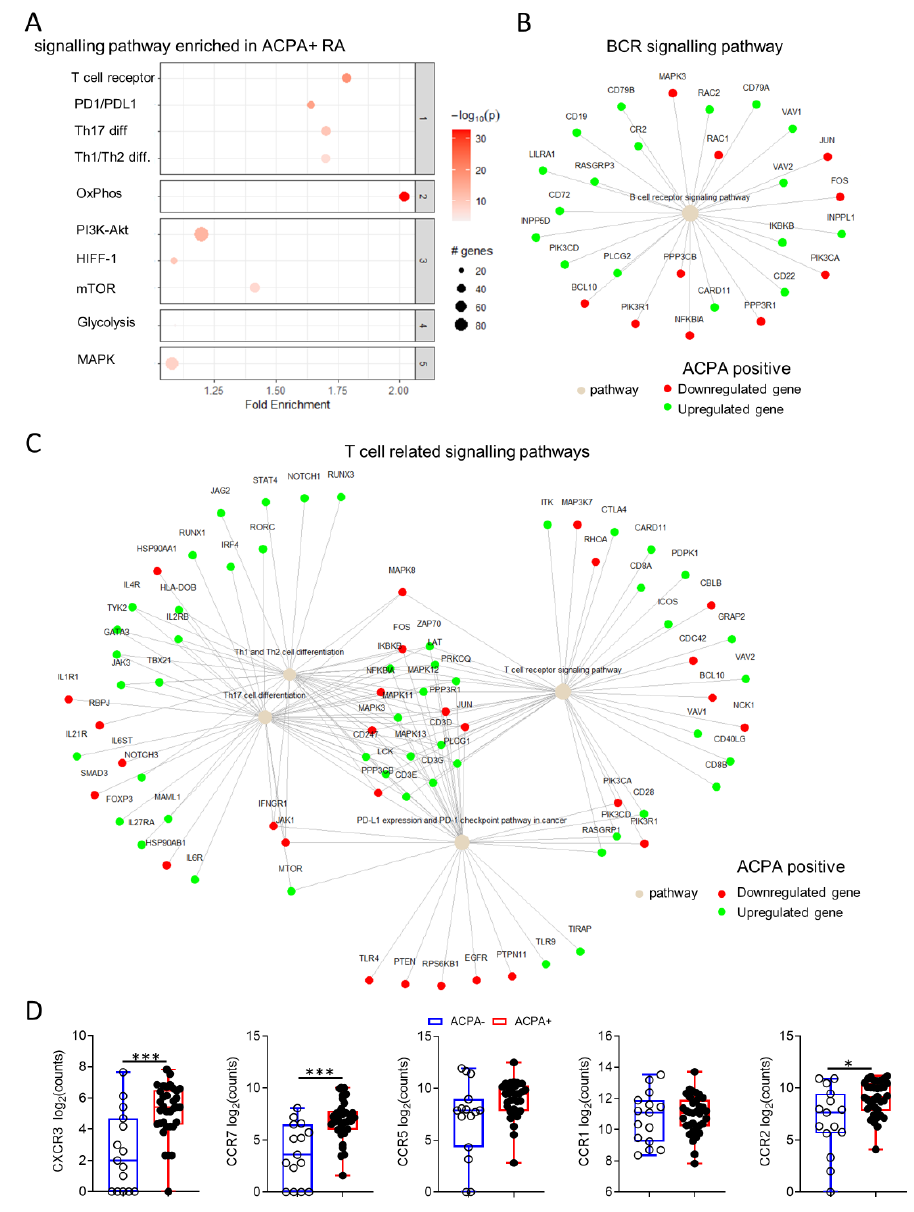
Figure 6. Distinct pathway enrichment in ACPA − and ACPA+ RA patient synovial tissue. ( A ) Enrichment plot of selected pathways enriched in APCA+ compares to ACPA- RA patient synovial tissue. ( B ) B cell receptor signalling pathway term plot showing specific gene up- or downregulation in ACPA+ compared to ACPA − RA patient synovial tissue. ( C ) Term plot of specific gene up- or downregulation for the top 3 most upregulated T cell dependent pathways in ACPA+ compared to ACPA − RA patient synovial tissue. ( D ) Data (log2(counts+1)) are presented as Box and whiskers plots (min to max), symbols represent individual samples. Statistical analysis was performed by using two-tailed Mann-Whitney test, p < 0.05 * were considered significant ( p < 0.01 ***). (VST) was performed in R (package DESeq2, function vst) (Figure S4B) [30]. While there is ACPA+ and ACPA − RA patient synovial tissue RNAseq data (Figure